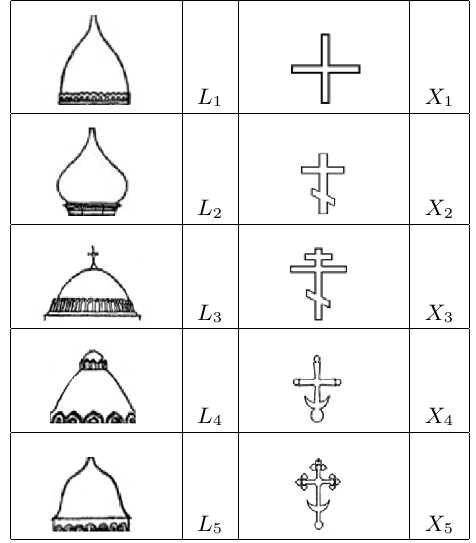
Table 2: Geometries of church components in the region of the golden ring (central region of